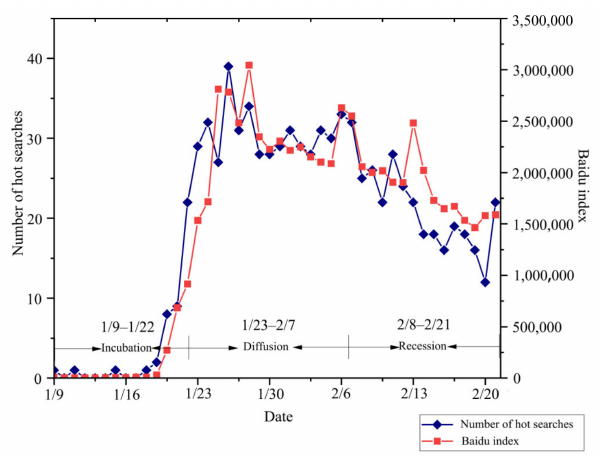
Figure 1. The changes of the number of Weibo hot searches and the Baidu index. (9 January 2020